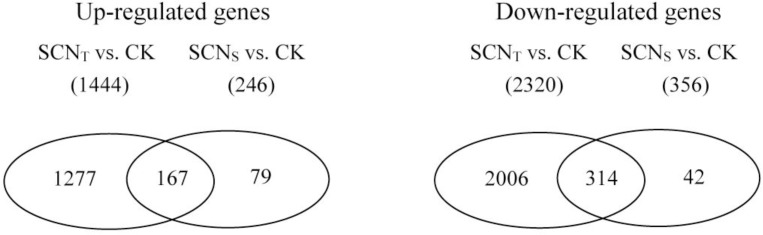
Venn diagrams presenting common and unique DEGs in resistant (SCNT vs. CK) and susceptible (SCNS vs. CK) interactions.In total, 481 genes were common between the two interactions.